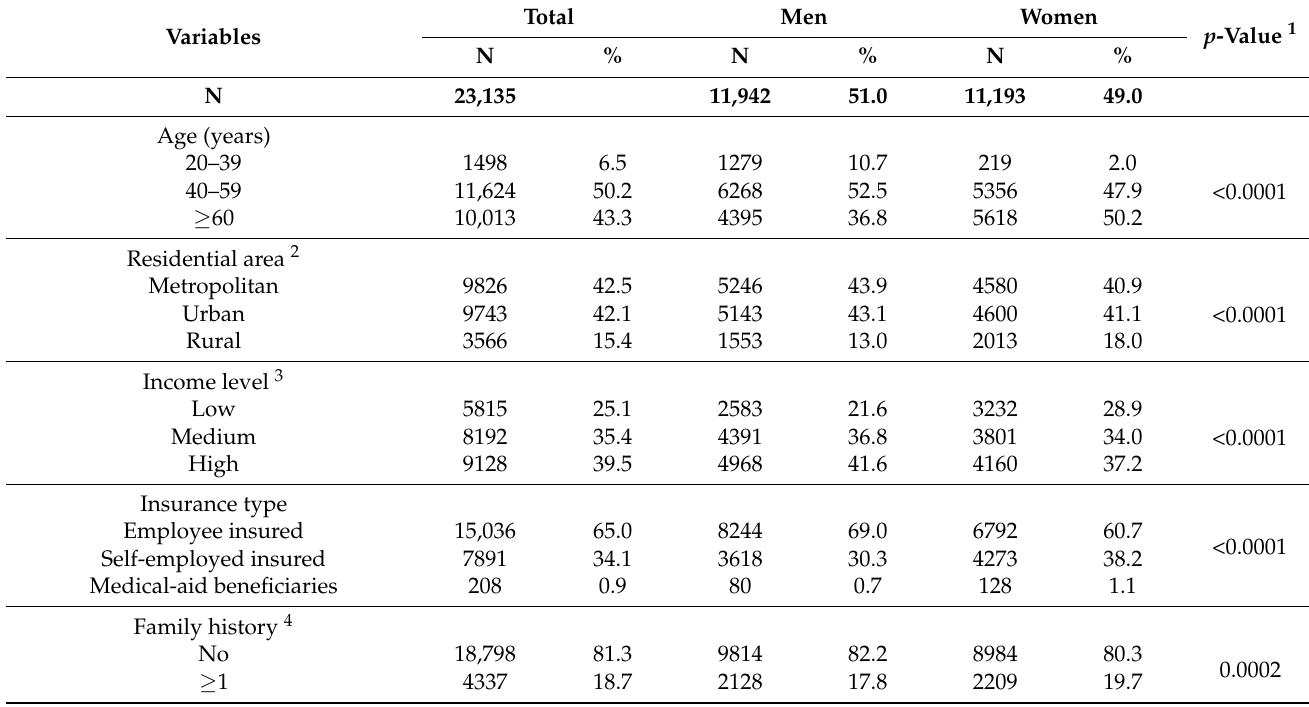
Table 1. General characteristics of hypertensive patients at